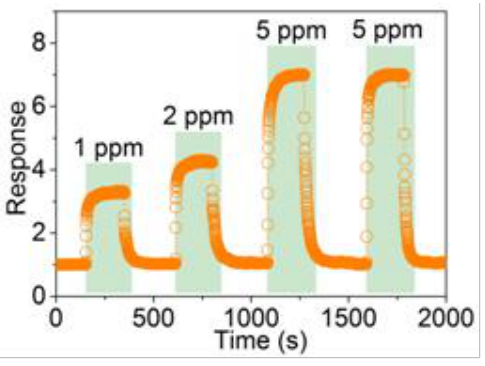
Figure 8. Four period response curves of the 3DIO WO 3 sensor to different acetone concentrations.